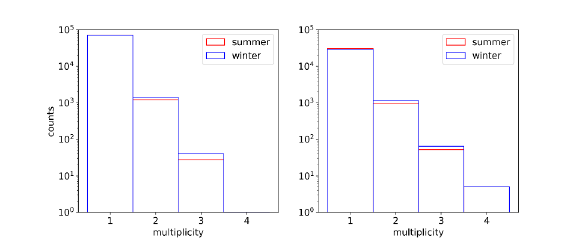
Figure 3: Muon multiplicity distribution from θ = 50 ◦ zenith angle showers and energies of 50 TeV (left) and 100 TeV (right) for summer (red) and winter (blue).